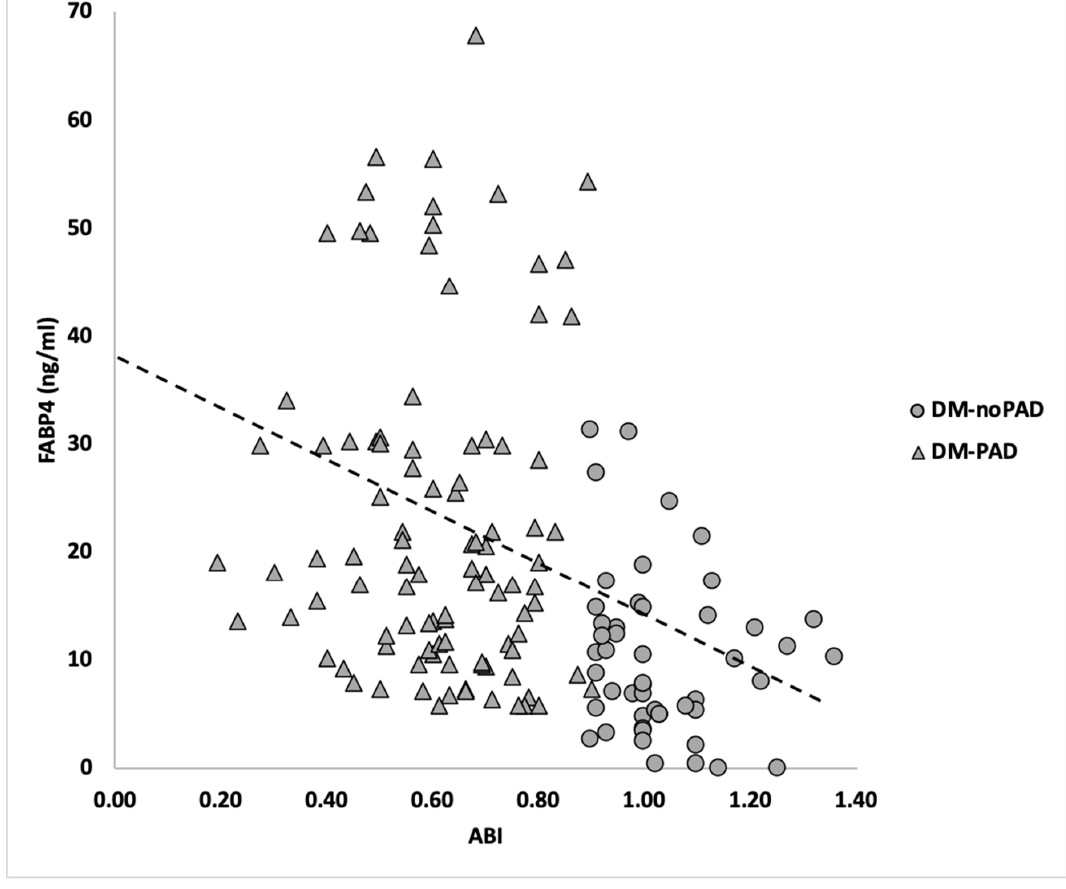
Figure 1. Relationship between FABP4 and DM-PAD. Spearman correlation between ankle brachial index (ABI) and fatty acid binding protein 4 (FABP4) in DM-noPAD (diabetic patients without peripheral arterial disease, n = 49, circles) and DM-PAD (diabetic patients with peripheral arterial disease, n = 119, triangles). FABP4 values were inversely correlated to the ABI using spearmen correlation (r = − 0.374, p -value =